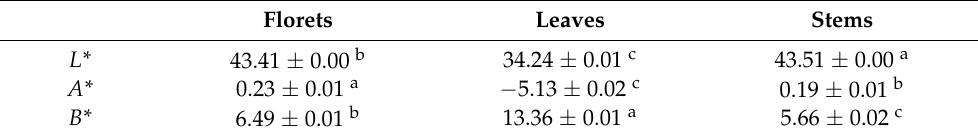
Different letters in a row indicate statistically significant ( p -value < 0.05) differences between the samples.